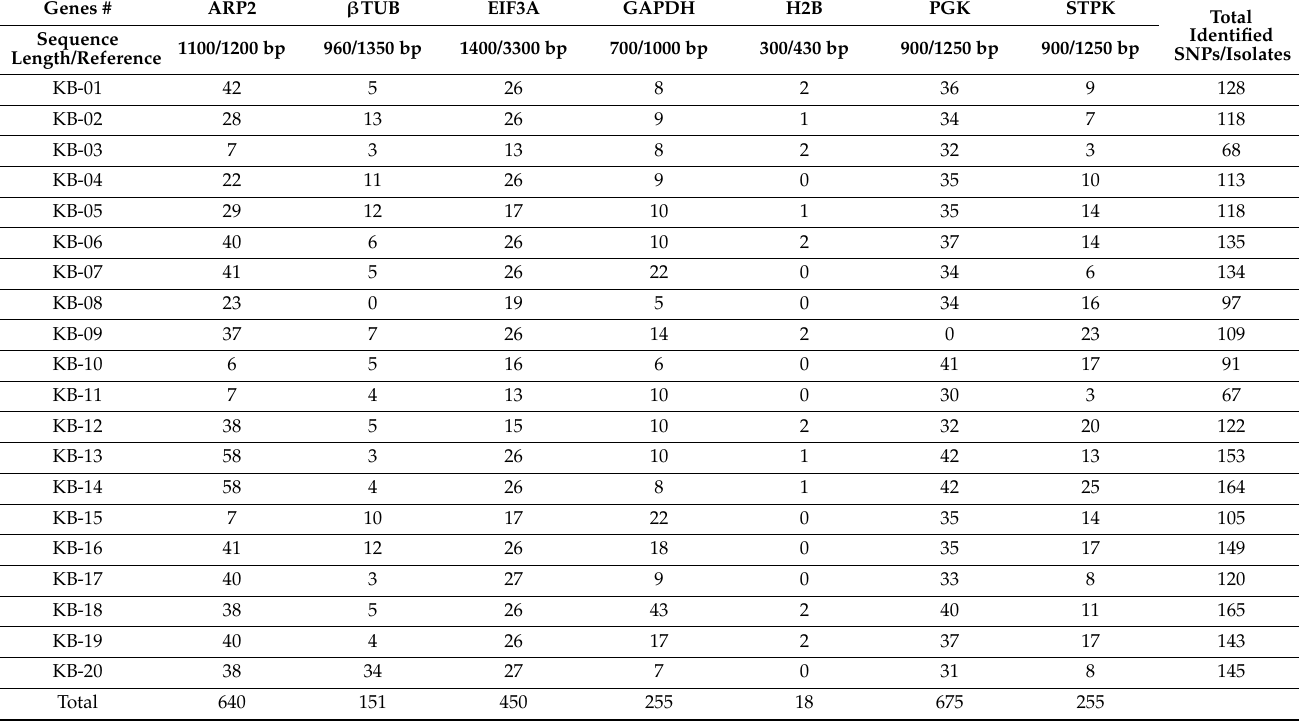
Table 3. Single nucleotide polymorphism (SNP) with respect to housekeeping genes in different isolates of Tilletia indica